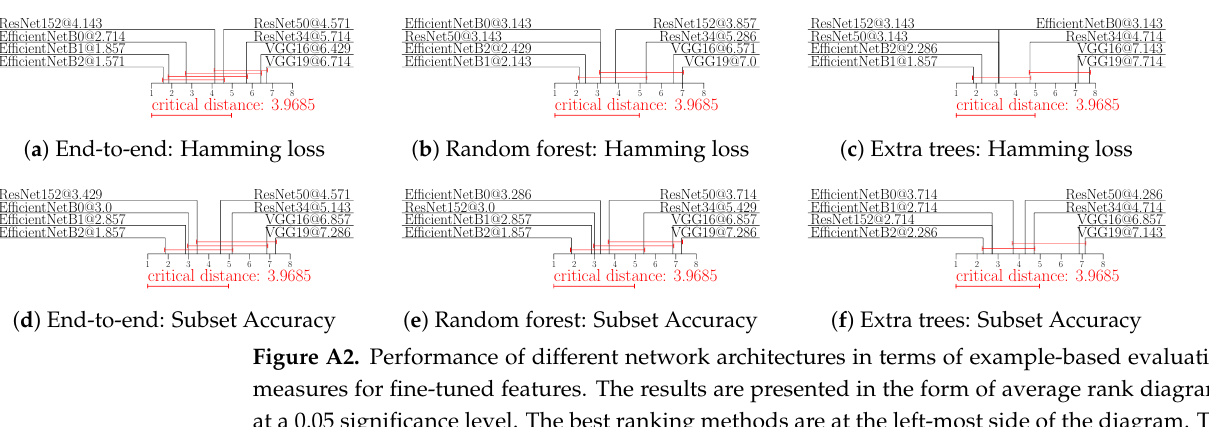
Figure A1. Performance of different network architectures in terms of label-based evaluation mea- sures for fine-tuned features. The results are presented in the form of average rank diagrams at a 0.05 significance level. The best ranking methods are at the left-most side of the diagram. The difference among the methods connected with a red line is not statistically significant.